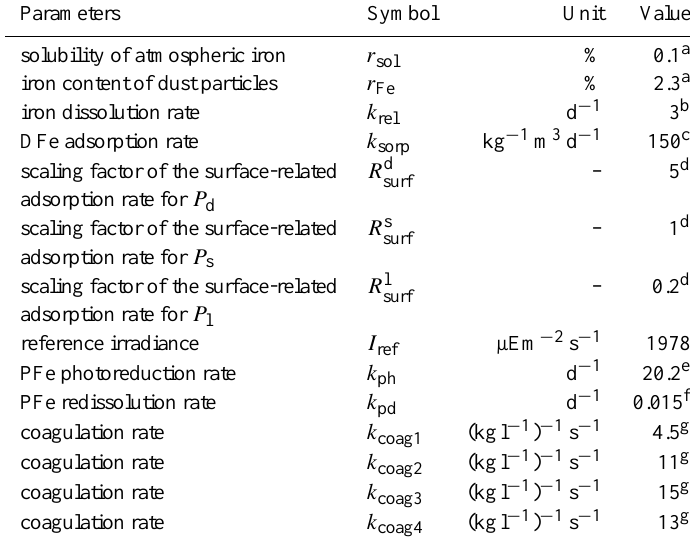
Table 3. Parameters in the chemical model.